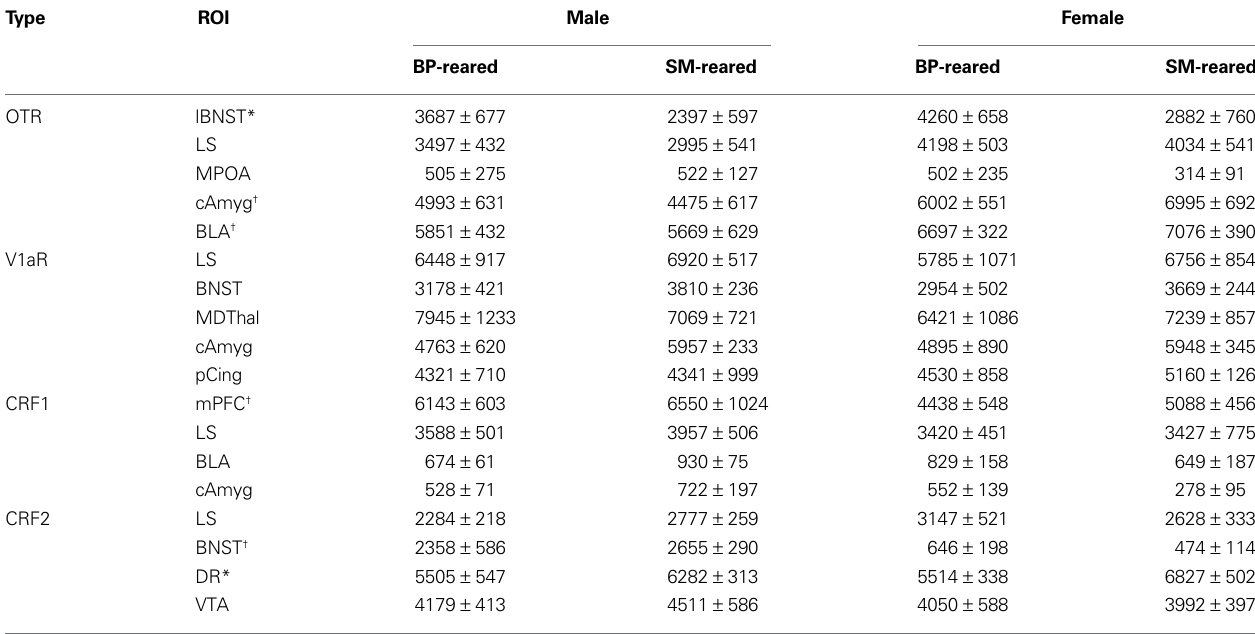
Table 2 | Autoradiographic receptor binding densities.